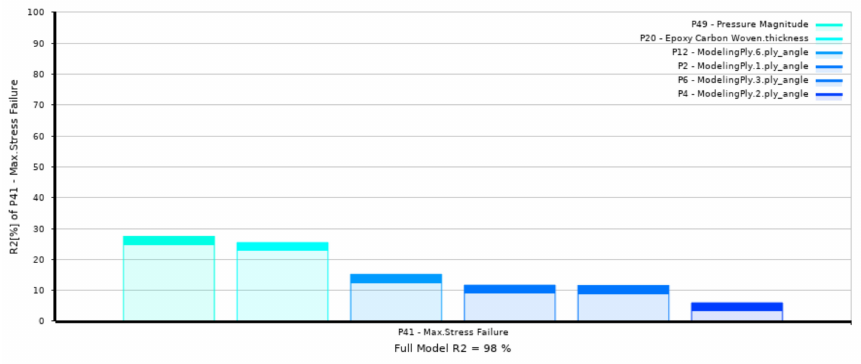
Figure 23. Sensitivities of max stress